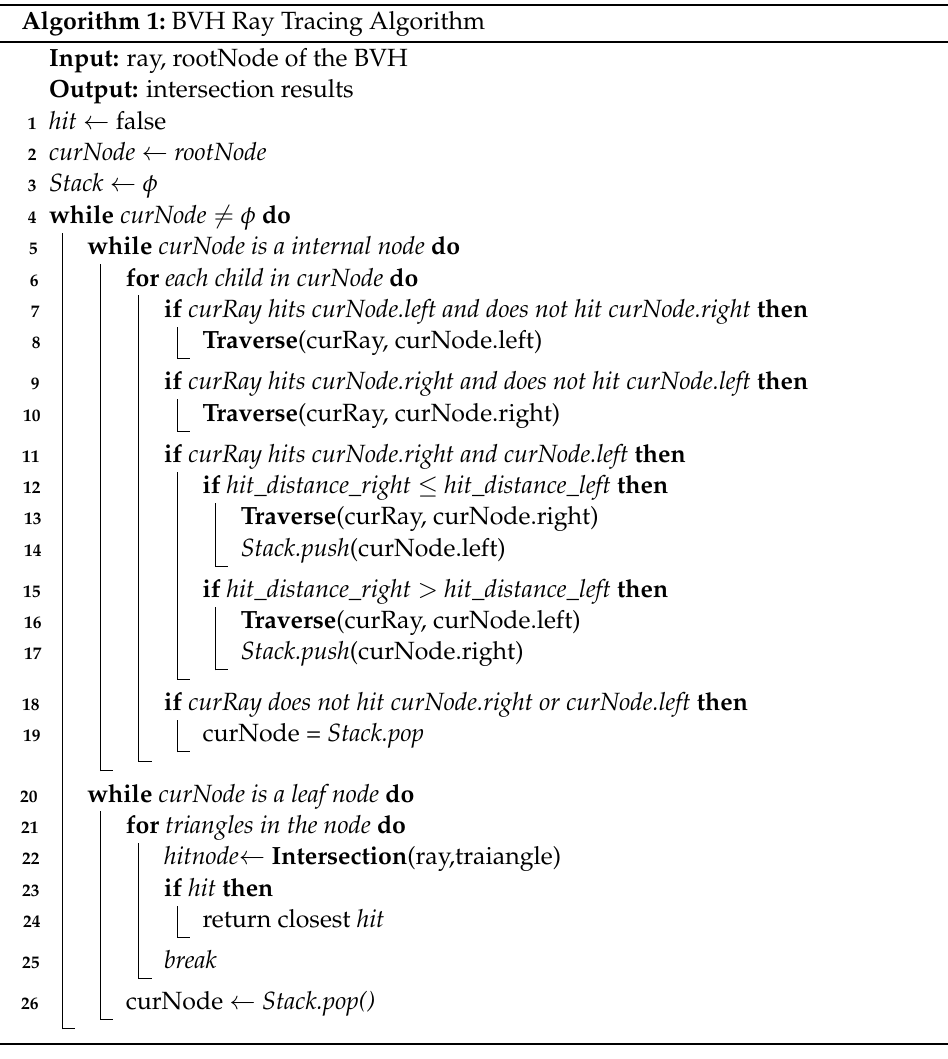
Algorithm 1: BVH Ray Tracing